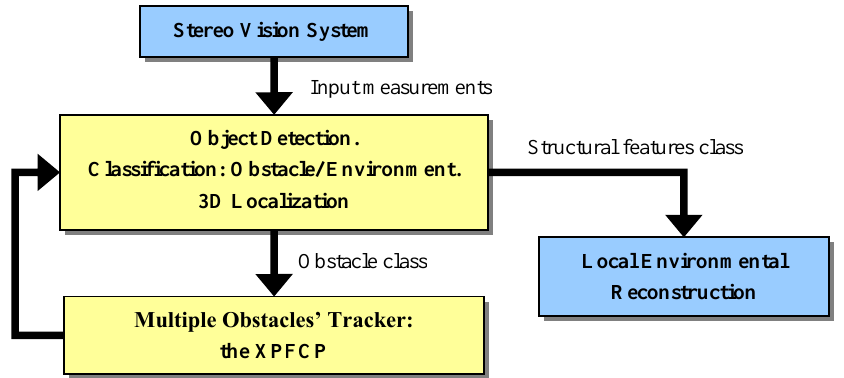
Figure 2. General description of the global stereo vision based tracking